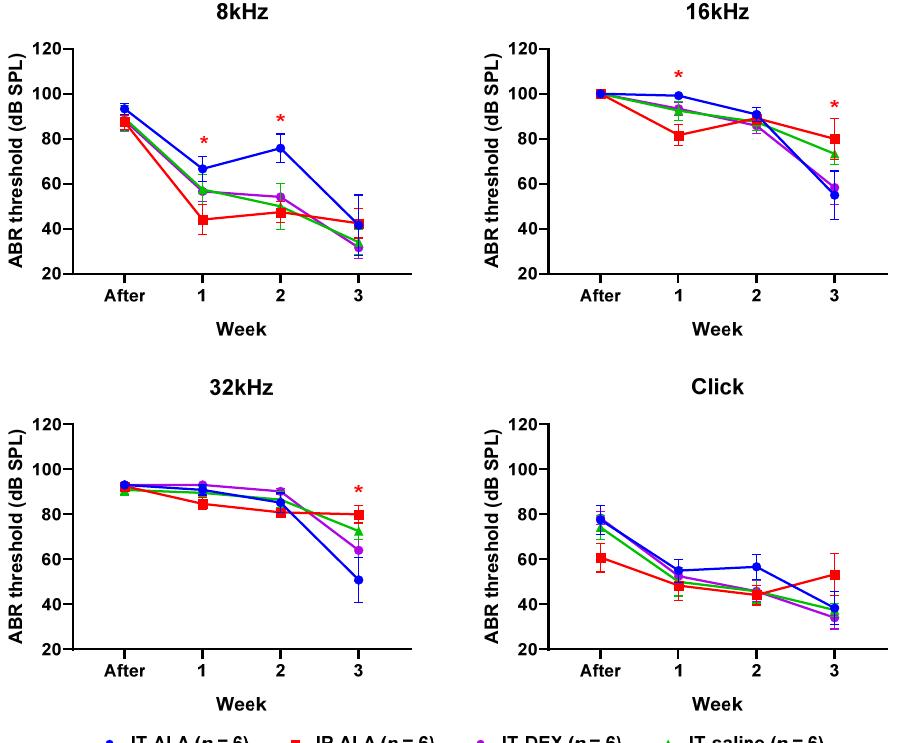
Figure 5. ABR thresholds. Mice in the IP ‐ ALA group showed significantly better hearing than mice in the IT ‐ ALA group at lower frequencies (8 kHz and 16 kHz) at 1 and 2 weeks after noise exposure. The IT ‐ ALA group showed better hearing at 16 kHz and 32 kHz frequencies than the IP ‐ ALA group 3 weeks after noise exposure. Significant difference was not observed between IT ‐ ALA and IT ‐ DEX groups. ABR, auditory brainstem response; IT, intratympanic; ALA, ɑ ‐ lipoic acid; DEX,